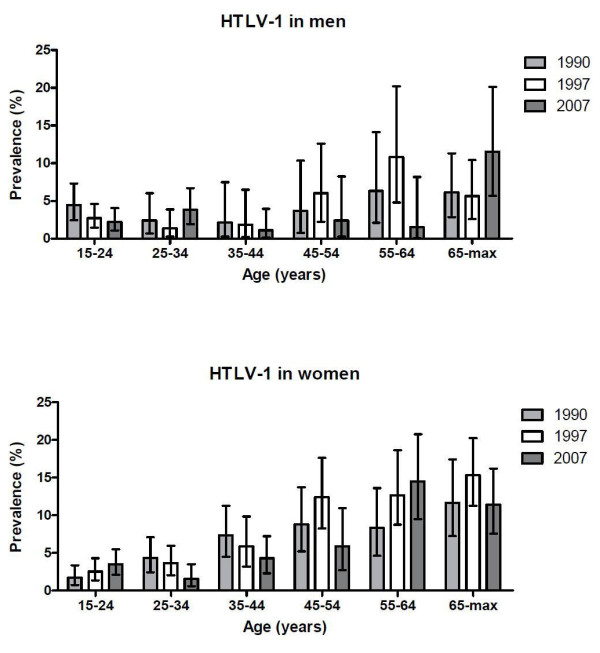
HTLV-1 prevalence by age and survey year (1990, 1997 and 2007) in men and women in Caió, Guinea-Bissau. Bars represent 95% confidence intervals; the 1990 figures differ slightly from the figures in B. Holmgren et al., JAIDS 2003, due to use of a different age variable.